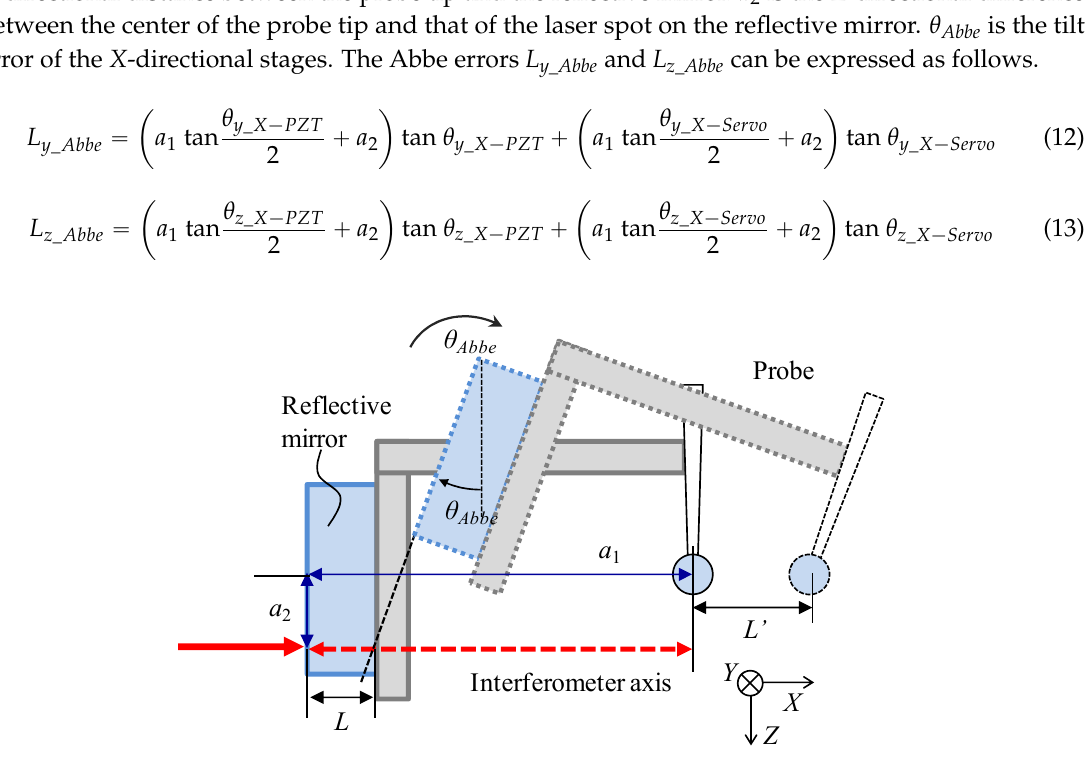
Figure 12. Schematic of Abbe error caused by the tilting motion of X ‐ directional moving stage.